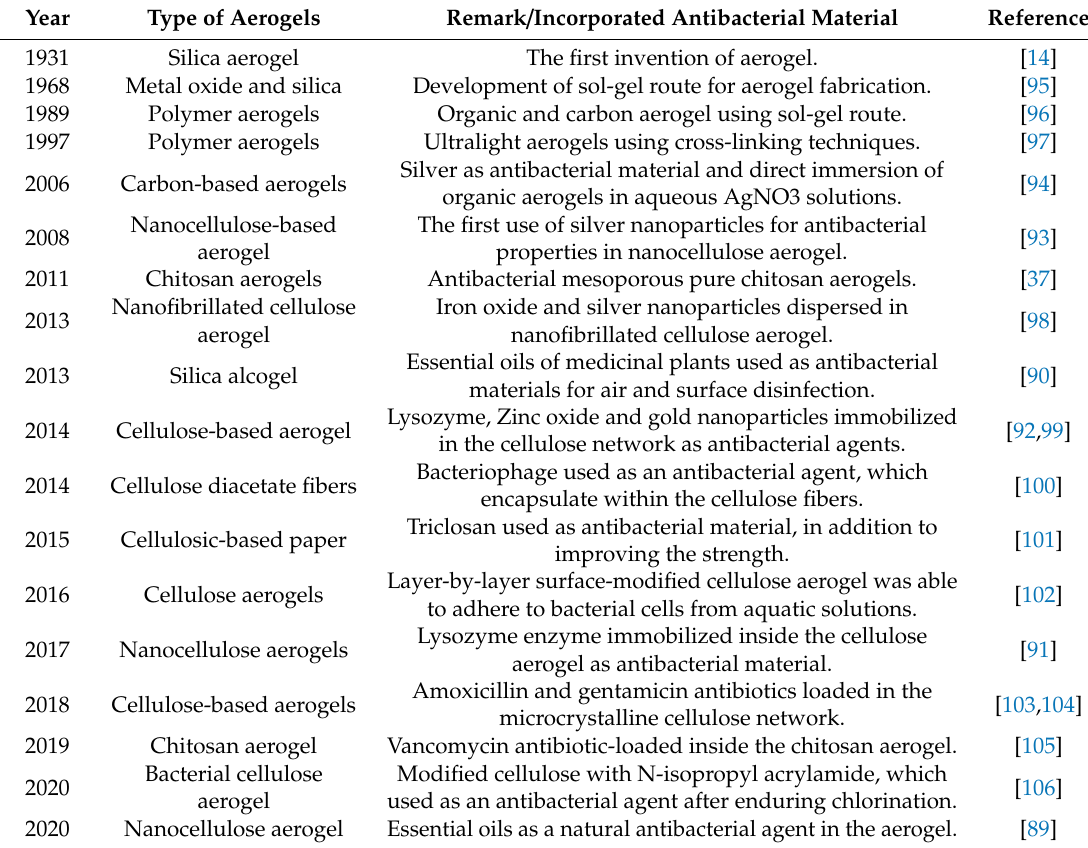
Table 2. Chronological development of the antibacterial